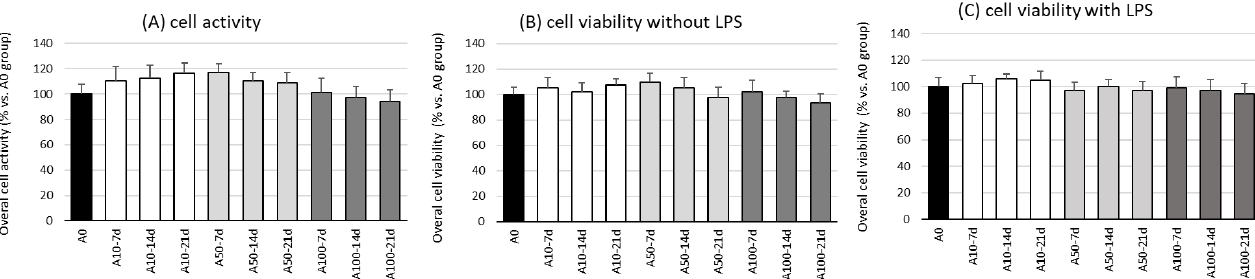
Figure 1. Effects of asprosin on overall cell activity measured in a CellTiter test ( A ) and viability ( B ) of adipocyte–macrophage co-cultures after 7, 14, and 21 days of differentiation, with lipopolysaccharide (LPS) or ( C ) without LPS (100 ng/mL) stimulation. The results from five independent experiments are expressed as mean + standard deviation (SD). Statistical significance ( p < 0.05) was determined by the Duncan t -test.